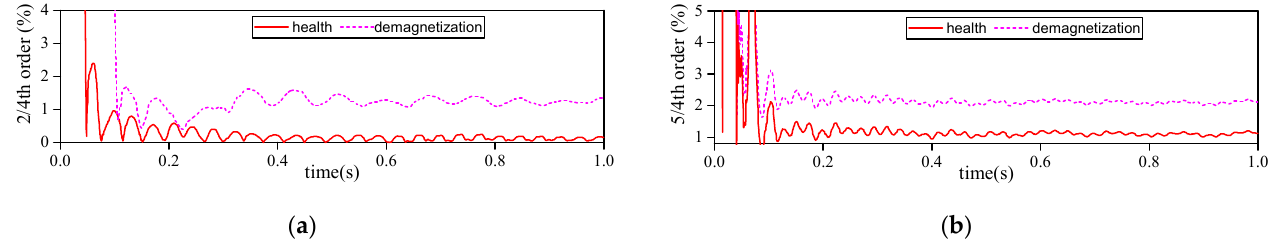
Figure 8. Comparison of harmonics between healthy and partially demagnetized PMSMs under stationary conditions: ( a ) 2/4th-order harmonic (1000 rpm, 0.6 A); ( b ) 5/4th-order harmonic (1000 rpm, 0.6 A).